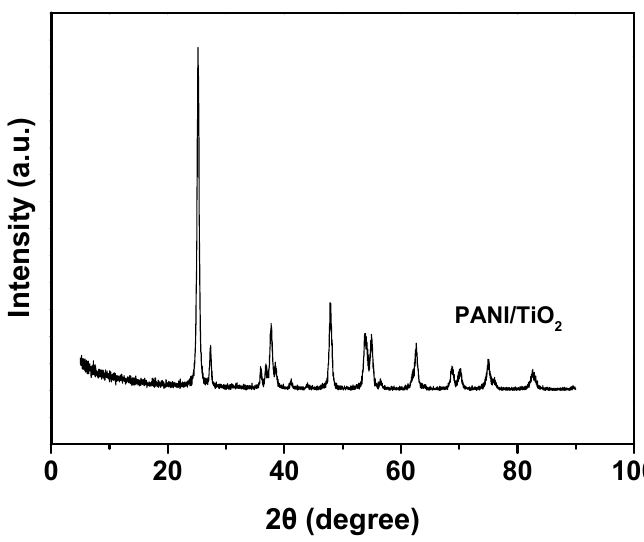
Figure 4. X-ray diffraction (XRD) pattern of PANI/TiO 2 composite.